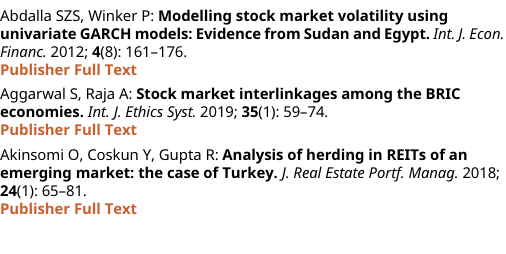
Figshare: Modelling time-varying volatility using GARCH models. https://doi.org/10.6084/m9.figshare.20681203.v2 (Ali et al.,